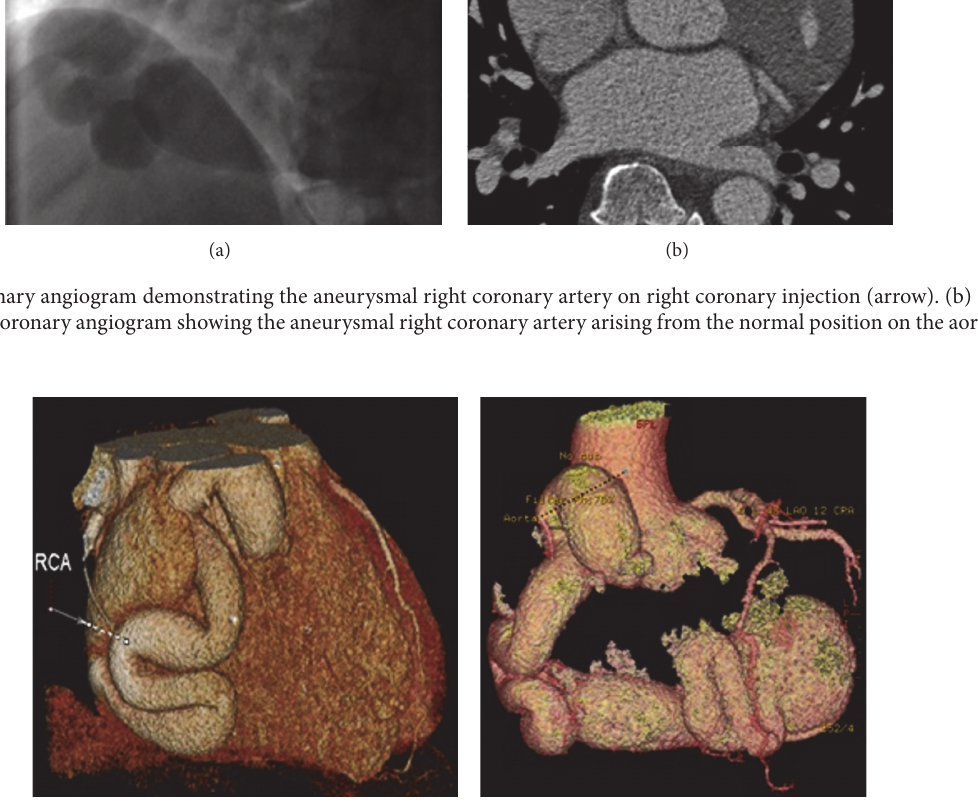
Figure 2: Three-dimensional reconstructions of CT images demonstrating the course of the aneurysmal right coronary artery on the surface of the